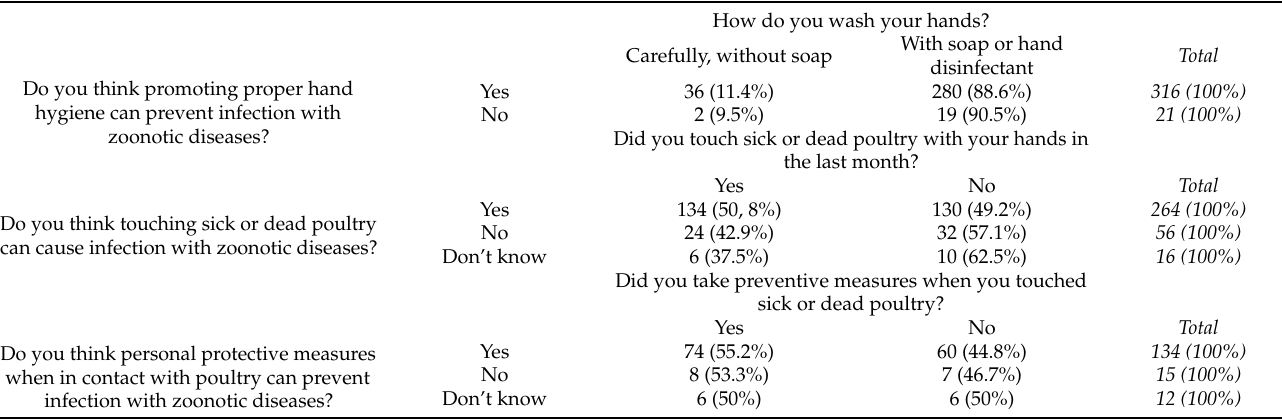
Table 4. Number and row percentage of respondents ( N (%)) stratified by attitude and related practice regarding hand hygiene and contact with